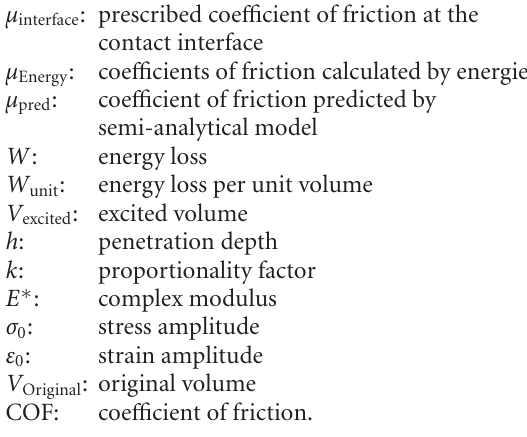
Figure 13: Coe ffi cients of friction of lubricated rubber/glass and rubber/steel sliding pairs measured at room temperature. (Based on the results of [19]). Oil viscosity = 65.9 mm 2